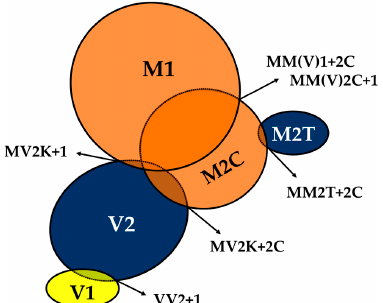
Figure 2. The spectrum of mixed phenotypes and prion strain co-occurrence in sporadic Creutzfeldt– Jakob disease (CJD). Prion strains are classified as “dominant” or “not-dominant” according to their relative quantitative contribution to the mixed CJD phenotype as assessed by histopathological examination and PrP Sc typing. The “dominant-only” strains are highlighted in blue, those either “dominant” or “not-dominant” in orange, and those “not-dominant-only” in yellow. The extent of overlap between circles reflects the relative prevalence of the strain co-occurrence compared to that of the individual “pure” phenotypes. In the M1+M2C strain co-occurrence, M1 dominates over M2C in the majority of cases. For strain nomenclature (e.g. M1, V2) see paragraph 6. This scenario represents an intriguing and mostly unexplained event, which is likely relevant to the understanding of prion strains. Several studies dealt with it, and the resulting data raised some debate in recent years concerning the extent of the phenomenon. Indeed, the calculated incidence of sCJD cases with the co-occurrence of PrP Sc types varied from 12% to 44% among studies that used standard antibodies against PrP C-terminus [45–50], but increased to 100% in those that used antibodies, thought to be selective for type 1, that recognize an epitope between residues 82 and 96,